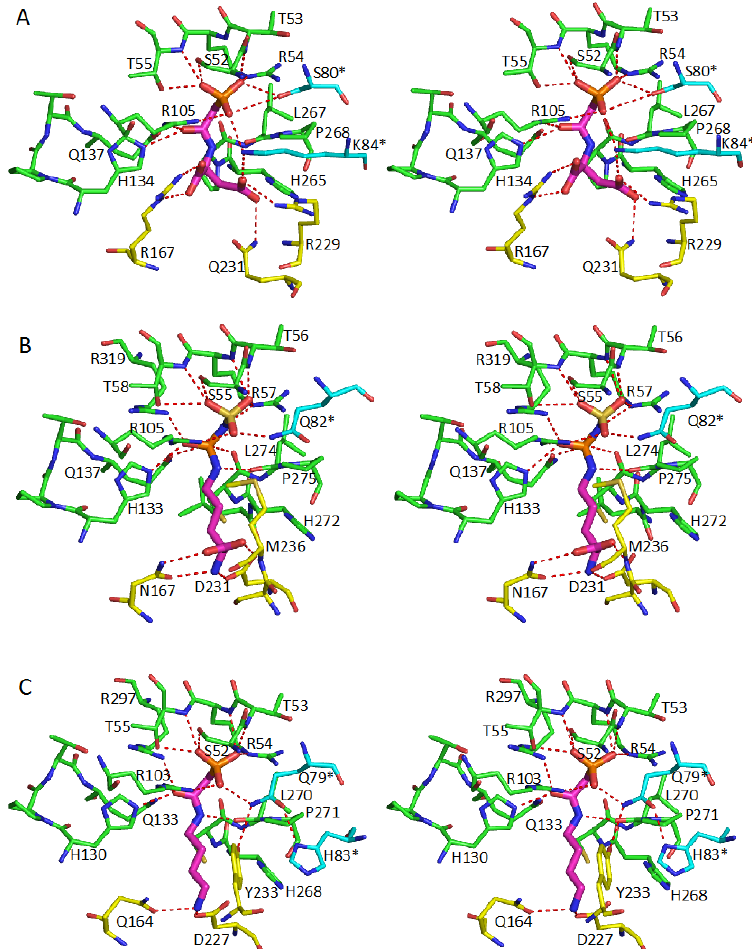
Figure 6. Stereo diagrams of the active sites of Escherichia coli ATCase ( A ); E. coli OTCase ( B ); and Enterococus faecalis PTCase ( C ). The residues involved in binding CP are shown as green sticks. The residues involved in binding the second substrate are indicated as yellow sticks. The residues from the adjacent subunit are indicated as cyan sticks. The bound substrates or inhibitor are shown as thick magenta sticks. The oxygen and nitrogen atoms are shown in red and blue sticks, respectively. The potential hydrogen bonding interactions are indicated by red dotted